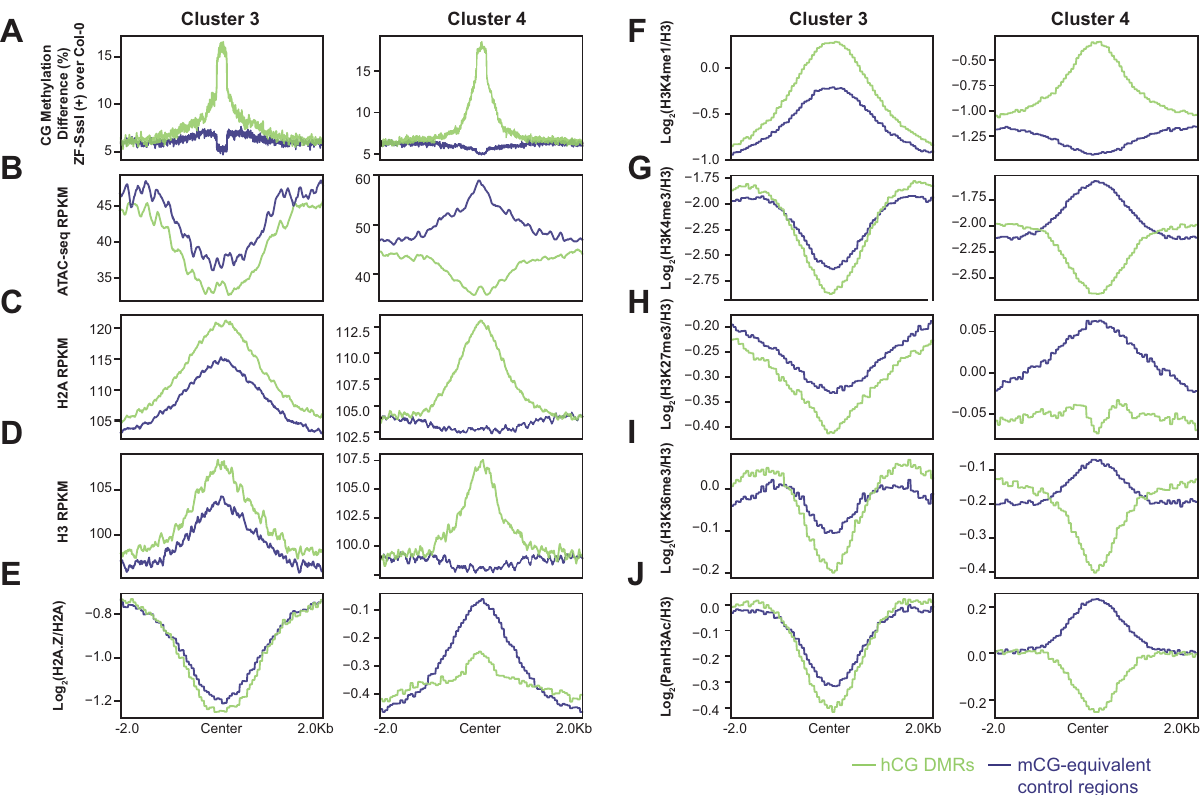
Fig. 4 The epigenetic landscape for hyper CG DMRs of Clusters 3 and 4 in Col-0. Metaplot of the CG methylation difference of ZF-SssI over Col-0 (ZF- SssI ( + ) lines during T2 and T3 merged) ( A ), ATAC-seq signals ( B ), H2A ( C ) and H3 ( D ) occupancy, H2A.Z ( E ), H3K4me1 ( F ), H3K4me3 ( G ), H3K27me3 ( H ), H3K36me3 ( I ), and PanH3Ac enrichment ( J ) over hyper CG DMRs and CG-methylation-equivalent control regions in Clusters 3 and marks in Col-0. We plotted the CG methylation difference, ATAC-seq signal, H2A, H3, H2A.Z, H3K4me1, H3K4me3, H3K27me3, H3K36me3, and PanH3Ac (Fig. 4, Supplementary